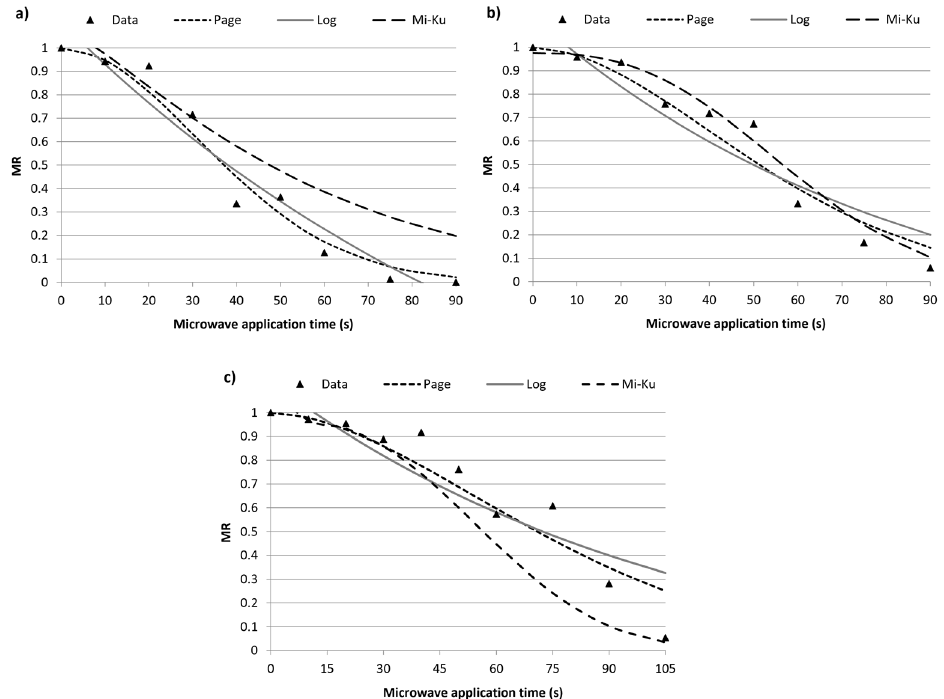
Figure 1. Microwave expansion kinetics of corn pellets with different mixture water contents (( a ): 25, ( b ): 30, and ( c ): 35 % ) adjusted to Page, Logarithmic, and Midilli–Kucuk models. Table 1. Values of the microwave expansion kinetic parameters obtained for pellets when the Page, Logarithmic, and Midilli–Kucuk models were used to fit the experimental data. Water Content of Mixtures (%)